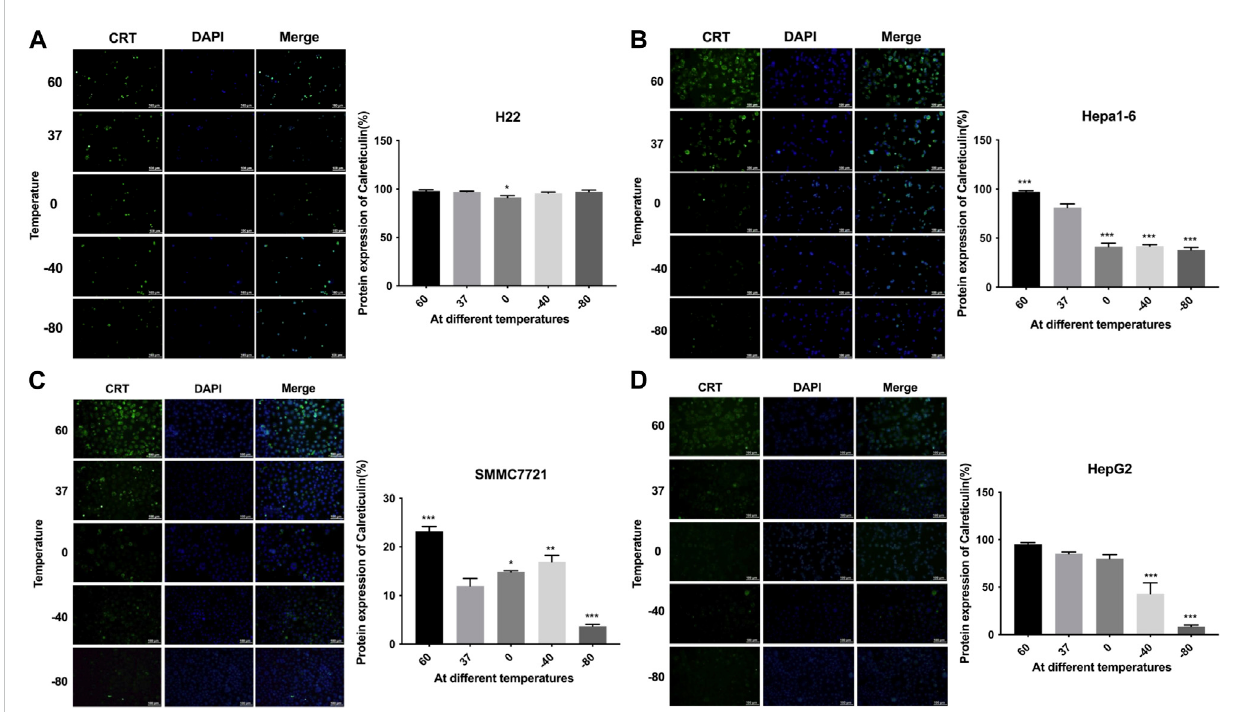
Immuno fl uorescence results of CRT expression of (A) H22 cells, (B) Hepa1-6cells, (C) SMMC7721 cells, and (D) HepG2 cells following different thermal ablations (* indicates p < 0.05, ** indicates p < 0.01 and *** indicates p < 0.001).